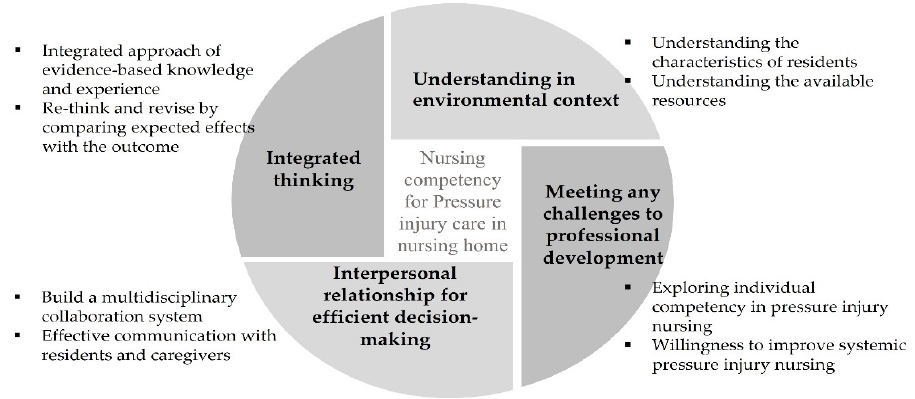
Figure 2. The framework of nursing competency for pressure injury management in nursing